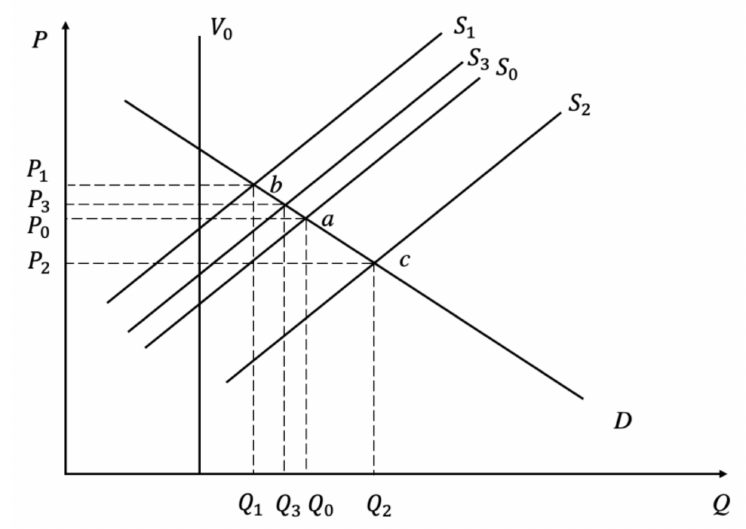
Figure 2. Market supply and demand shifts during different stages of salvage logging. Table 5. Summaries of literature using the intervention